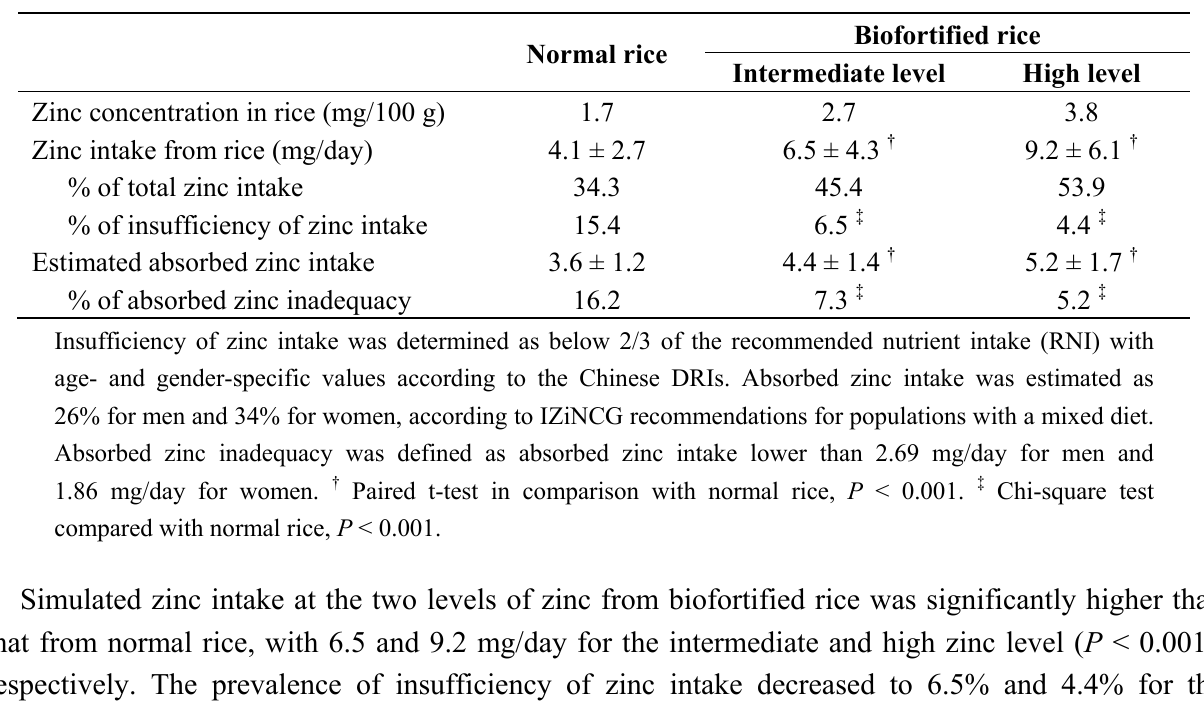
Table 3. Estimated zinc intake from a diet with normal rice and biofortified